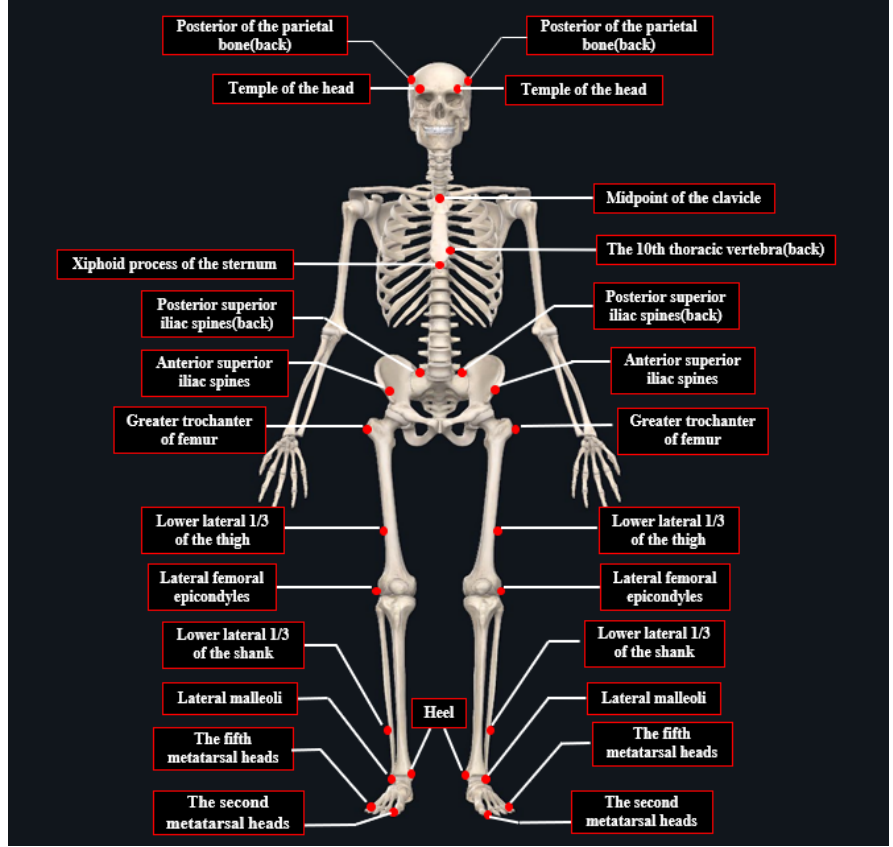
Figure 1. The anatomic location of the plug-in-gait lower limb model.